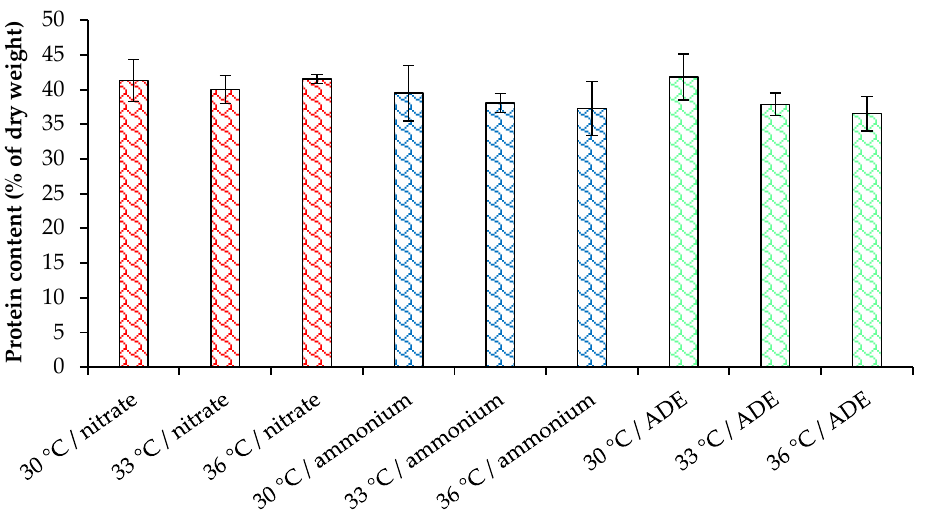
Figure 6. Protein content in cells of C. sorokiniana AM-02 cultured under different conditions. No significant differences were observed between treatments.